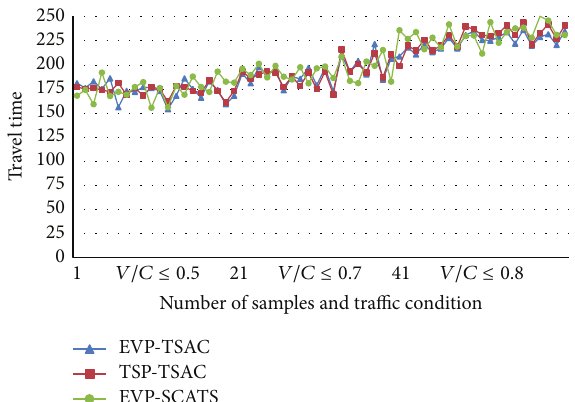
Figure 7: Transit travel time with 𝑉/𝐶 ≤ 0.8 for different traffic signal control scenarios.